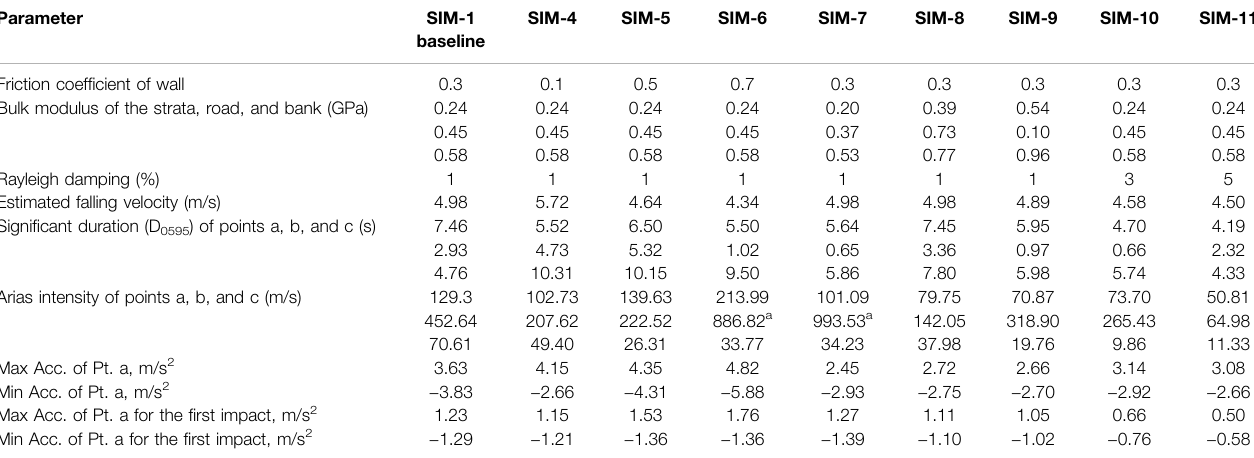
TABLE5| Parameterssettingsandresultsoftheparametricalstudyforsinglelargerockfall.Thefrictioncoef fi cientofwalls,bulkmodulus,andRayleighdampingwerevaried.